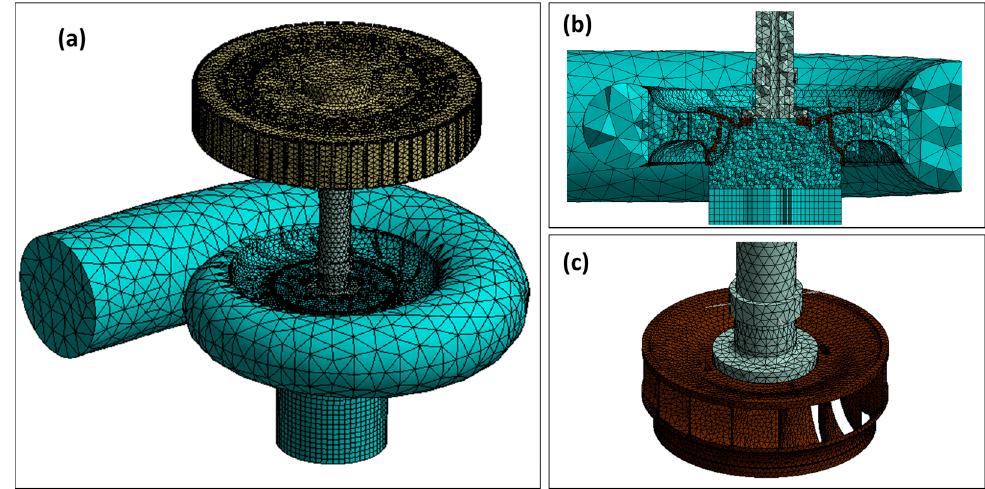
Figure 4. Finite Element Method (FEM) Model. ( a ) Isometric view; ( b ) Cross-section detail; ( c ) Runner mesh detail.